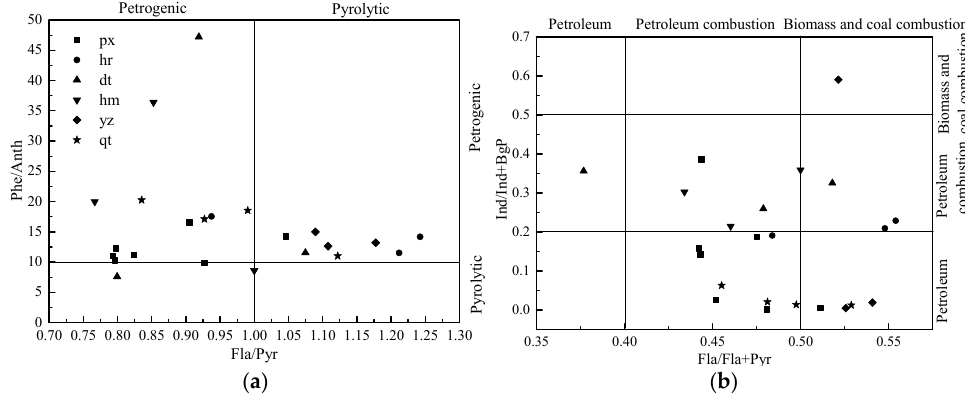
Figure 4. Source analysis of PAHs through diagnostic ratios. ( a ) Plot of Fla/Pry vs. Phe/Anth; ( b ) Plot of Fla/(Fla + Pyr) vs. Ind/(Ind + BgP).